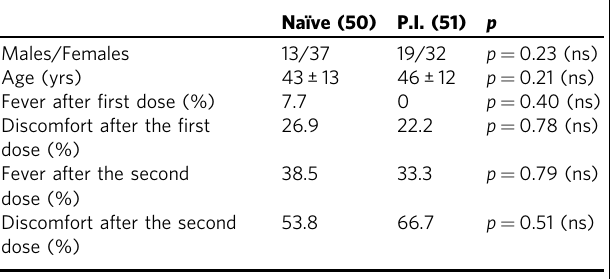
Table 1 Characteristics of the study population.